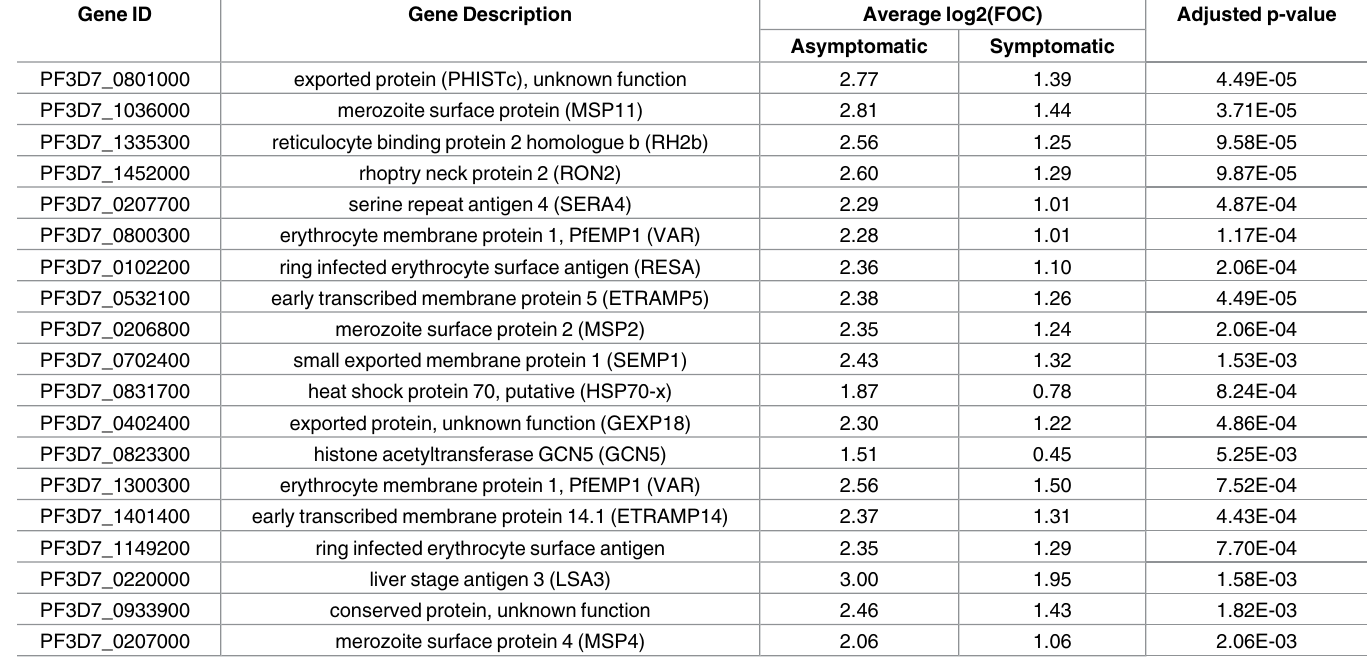
Table 3. Plasmodium falciparum antigens recognized with greaterintensity in asymptomatic individuals. Gene ID Gene